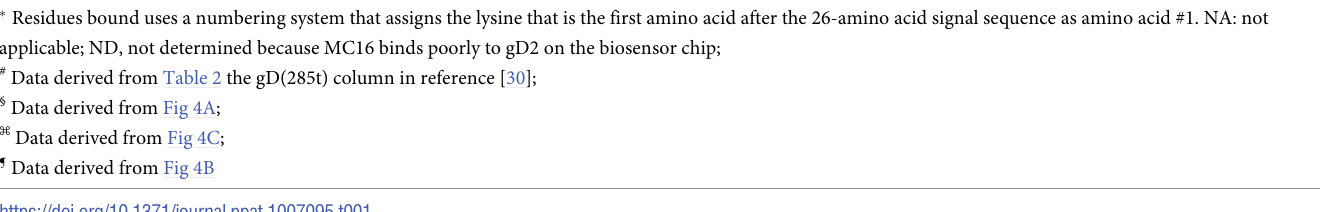
Table 1. Properties of MAbs used for passive transfer in mice. Community; Amino and prototype